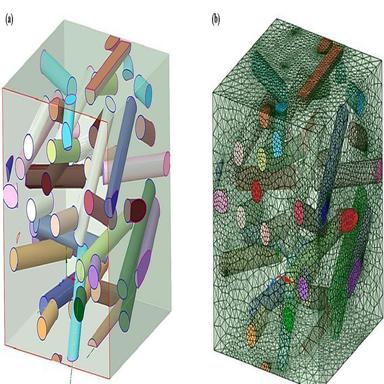
Microscale RVE showing (a) modeled RVE (b) meshed RVE with random fiber orientation.